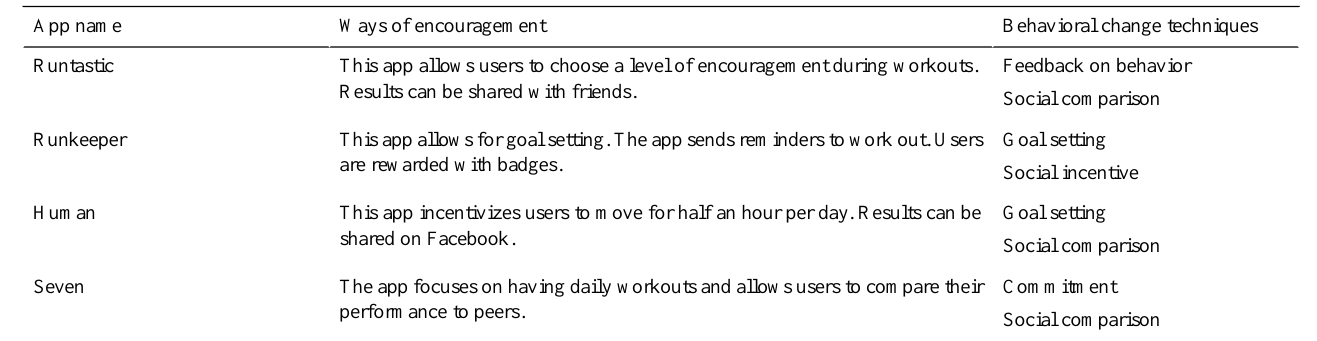
Table 2. Details of the apps